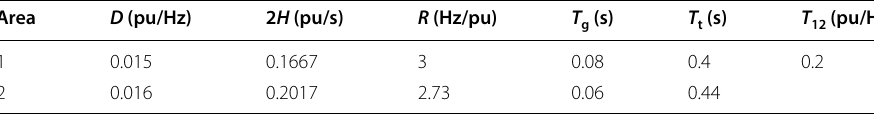
Table 1 Two-area power system network [26]